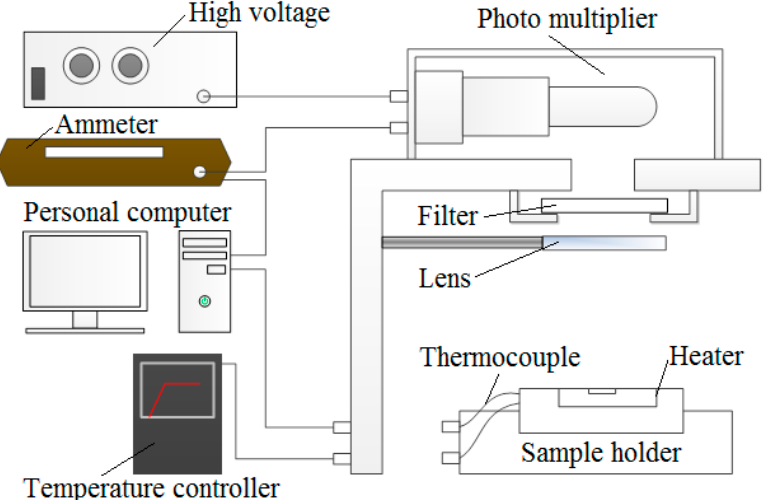
Figure 1. Schematic diagram of thermoluminescence (TL) measurement.